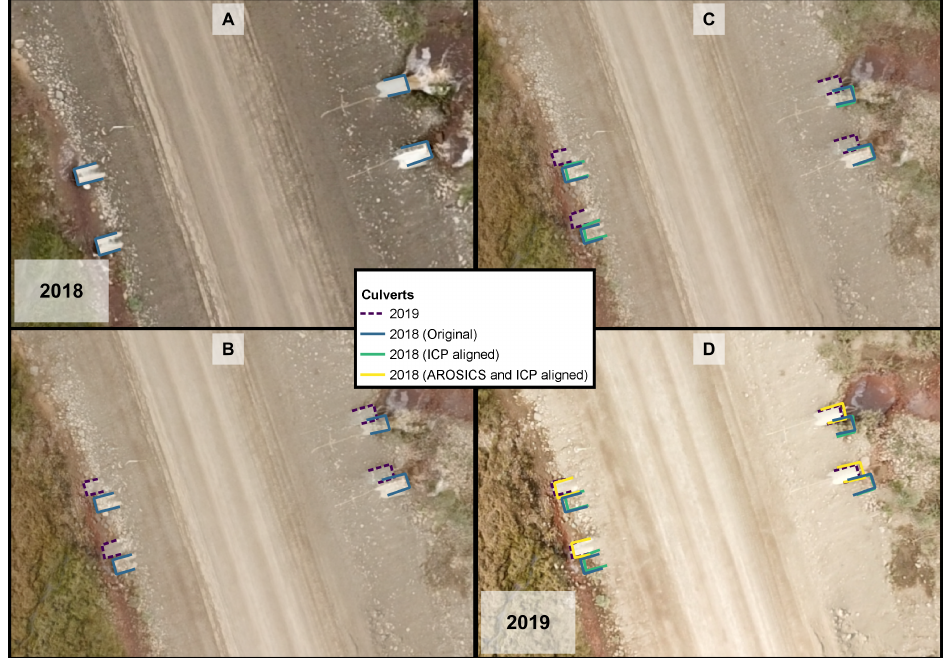
Figure 4. Results of the co-registration digitized along the culverts which drain the area west of Dalton Highway: ( A ) position of the culverts digitized on the basis of the original 2018 orthophoto mosaic (blue) and; ( B ) additional position in 2019 as reference (purple dashed line); ( C ) 2018 after ICP correction (green) and; ( D ) 2018 after AROSICS and ICP correction (yellow). (Background images: ( A ) orthophoto mosaic 2018, ( B , C )) orthophoto mosaic 2018 and 2019 overlaid with 50% transparency each and ( D ) orthophoto mosaic